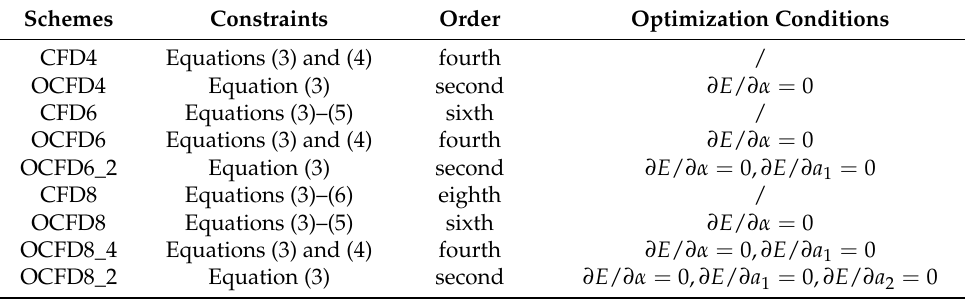
Table A1. All tridiagonal optimization schemes with different